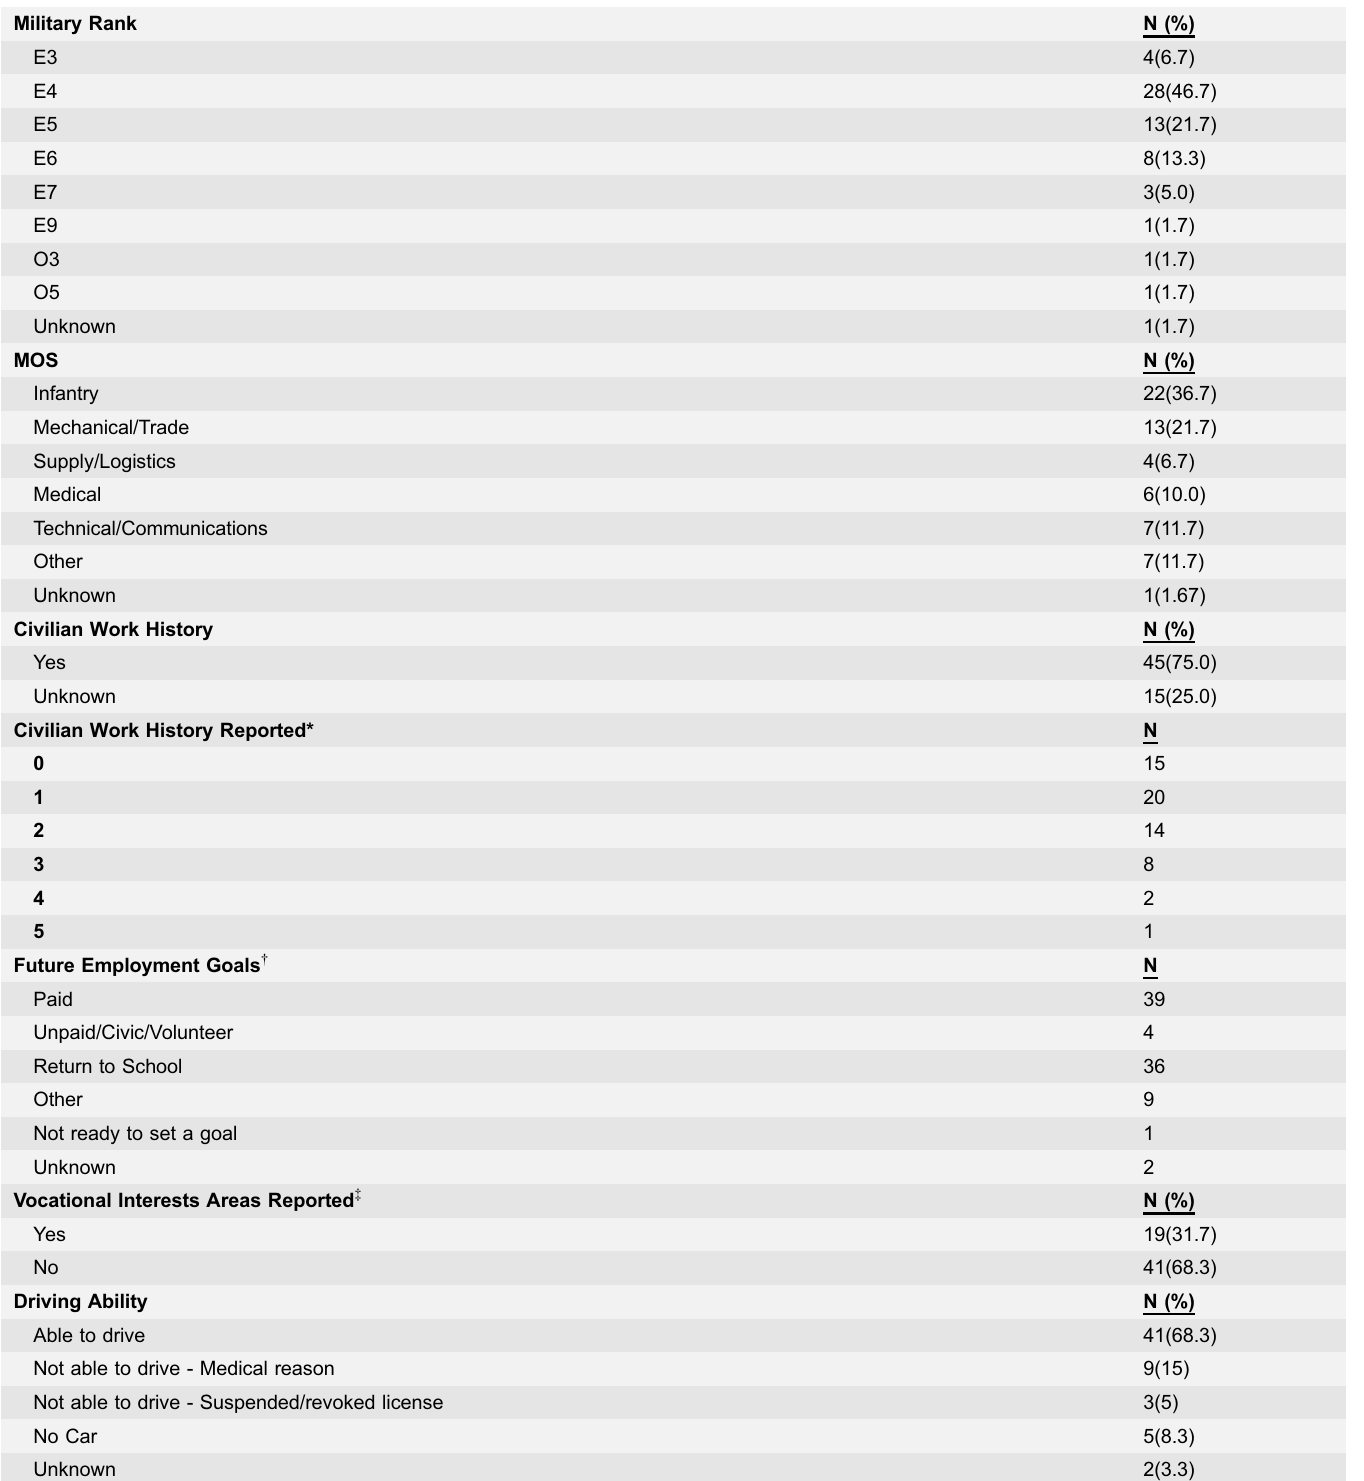
Table 4. Military Rank, MOS, Work History, Employment Goals, Vocational Interests & Driving Ability (N 5